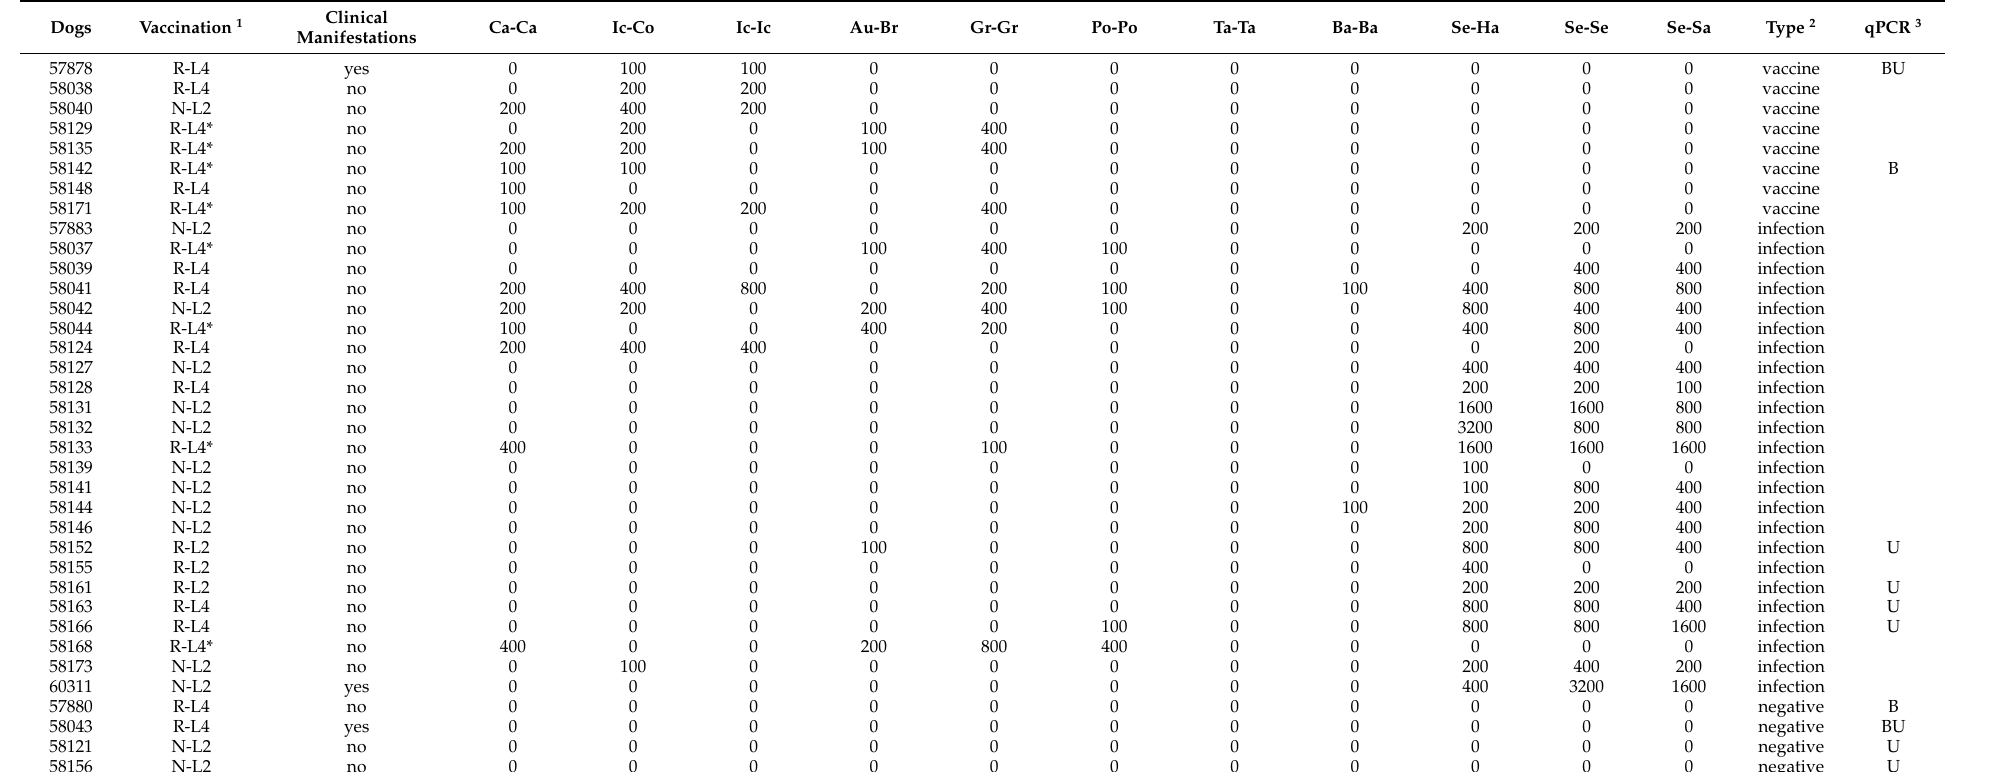
Table 2. Dogs that tested positive by MAT and/or qPCR